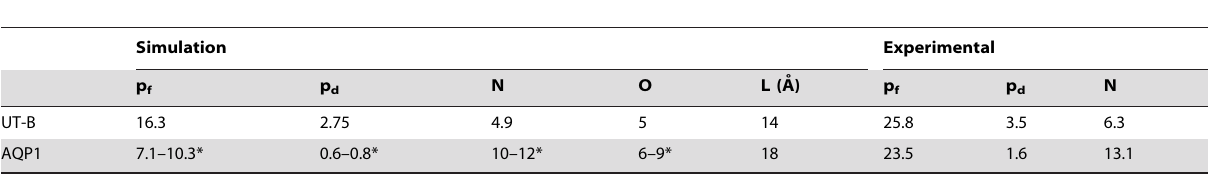
Table 3. Water conduction through UT-B and